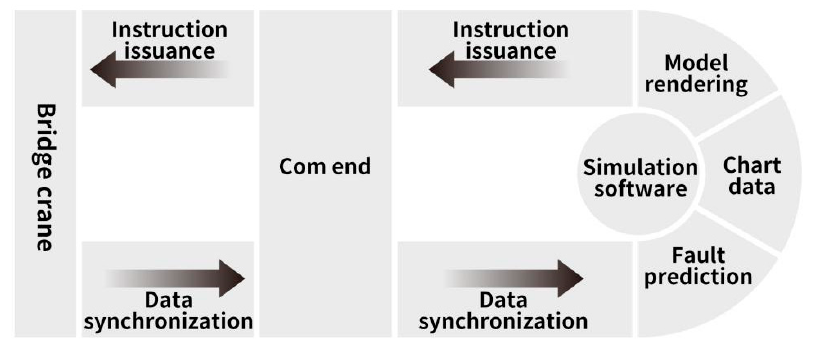
Figure 1. Design of the digital twin software.